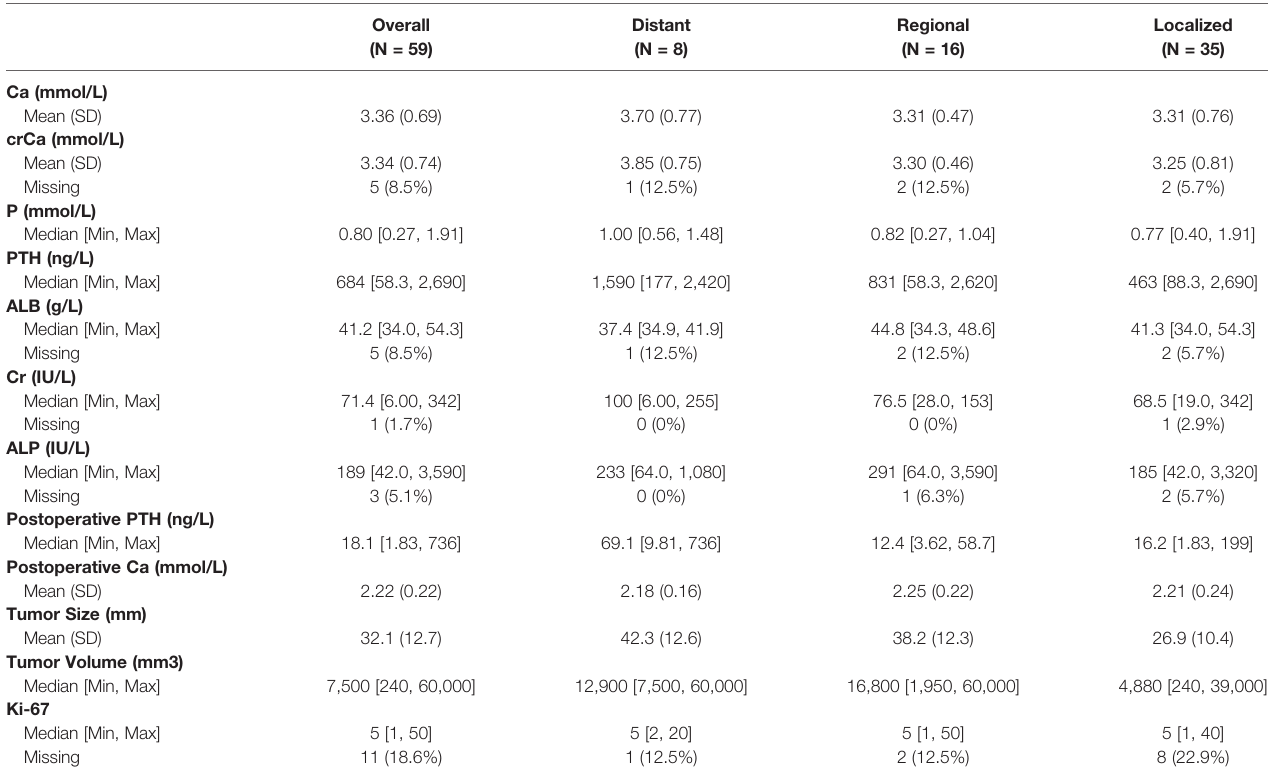
TABLE 4 | Laboratory and clinicopathologic indices of parathyroid carcinoma patients in the single Chinese centera. Overall